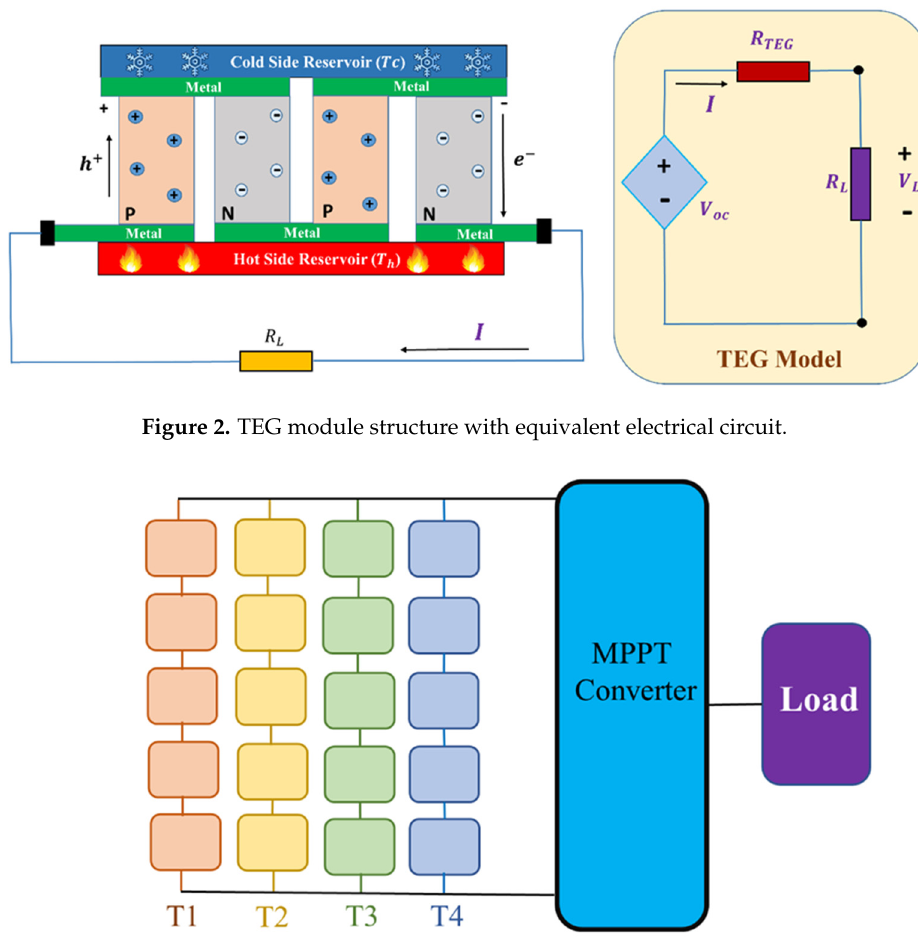
Figure 3. Centralized TEG con fi guration with load and MPPT converter.